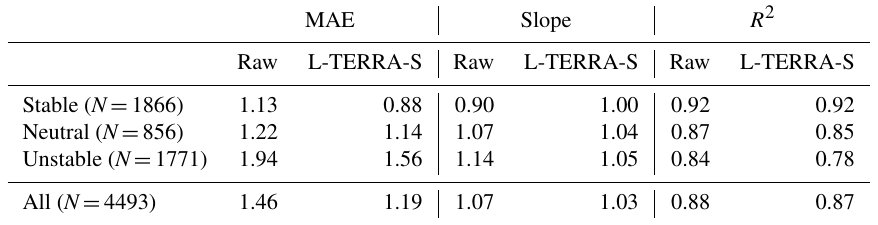
Table 4. As in Table 3 but for Southern Plains wind farm